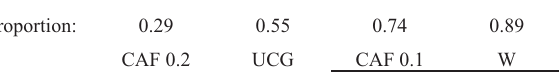
(p = 0.000). In this case, production in W differed from that in CAF 0.2 and UCG: